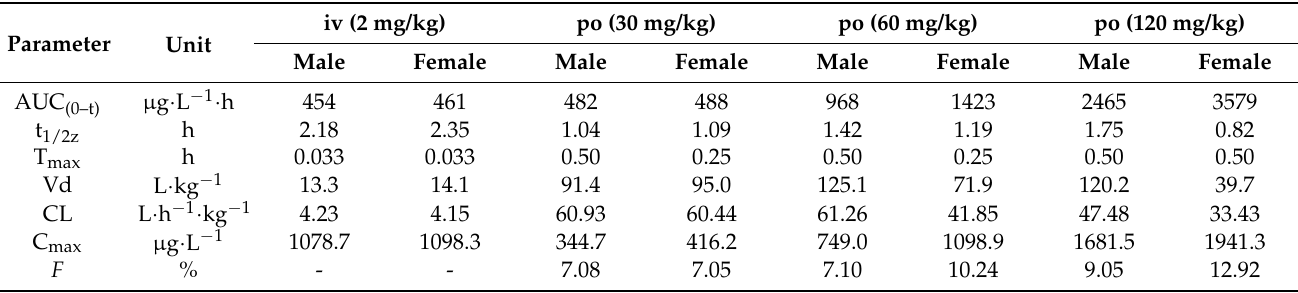
Figure 6. Plasma concentration–time profiles of K-5a2 in male ( A ) and female ( B ) BALB/c mice. Table 5. Pharmacokinetic profile of K-5a2.